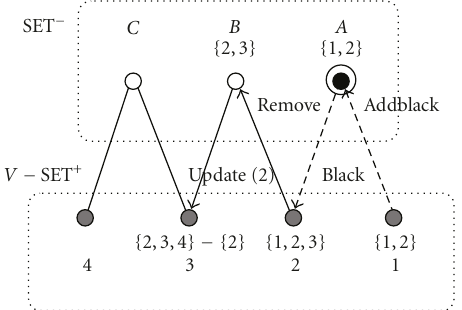
Figure 7: The size of finding COV is at most Δ opt c . opt c is the size of an optimal cover.